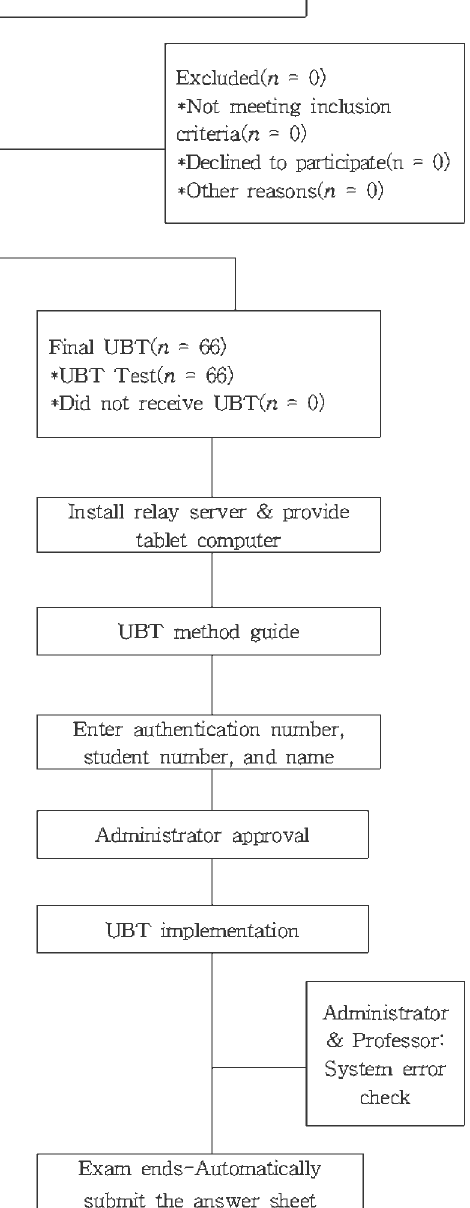
Figure 1. Flow diagram of the study. OMR = optical mark read; UBT = ubiquitous-based